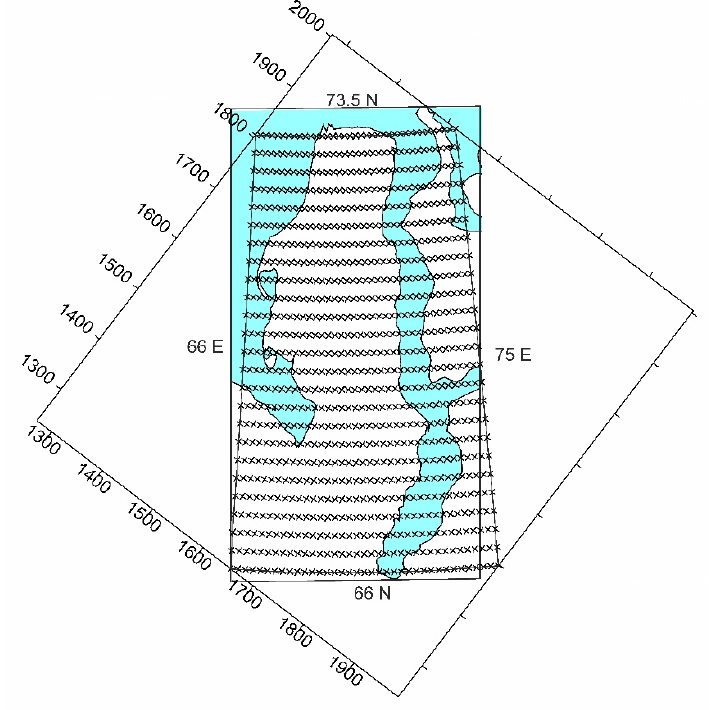
Figure 19. ERA5 grid and corresponding MSK-1964 coordinates (in km from datum) for the Yamal